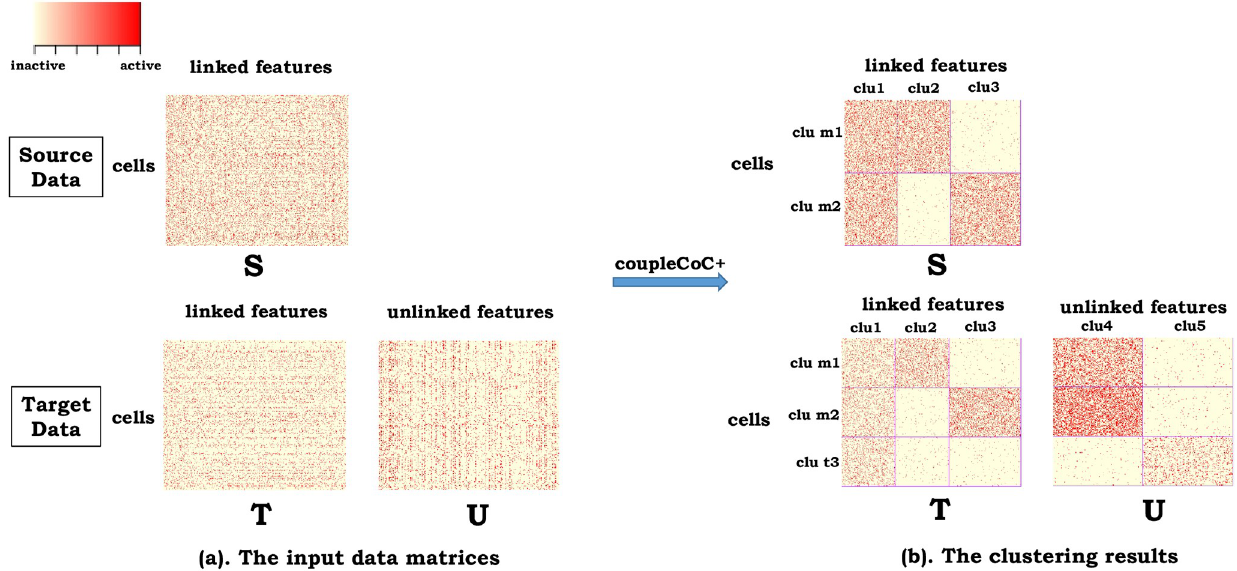
Fig 1. Toy example of couple CoC+. (a). Source data is represented by “S”. Based on whether the features are linked with those in the source data, we partition the target data into two parts, “T” and “U”. The features in data T are linked with data S, while the features in data U are not directly linked with data S. The cells in data T and U are the same. Red color means that the corresponding features are active, and yellow color means that they are inactive. (b). The clustering results by couple CoC+. couple CoC+ co-clusters the data S, T and U simultaneously by clustering similar cells and similar features. A subset of the cell clusters are also matched between the source data and the target data, representing shared cell types. “clu” is the abbreviation of “cluster”, and “m” means the matched clusters. “clu t” represents the cell cluster that is unique to the the target data.